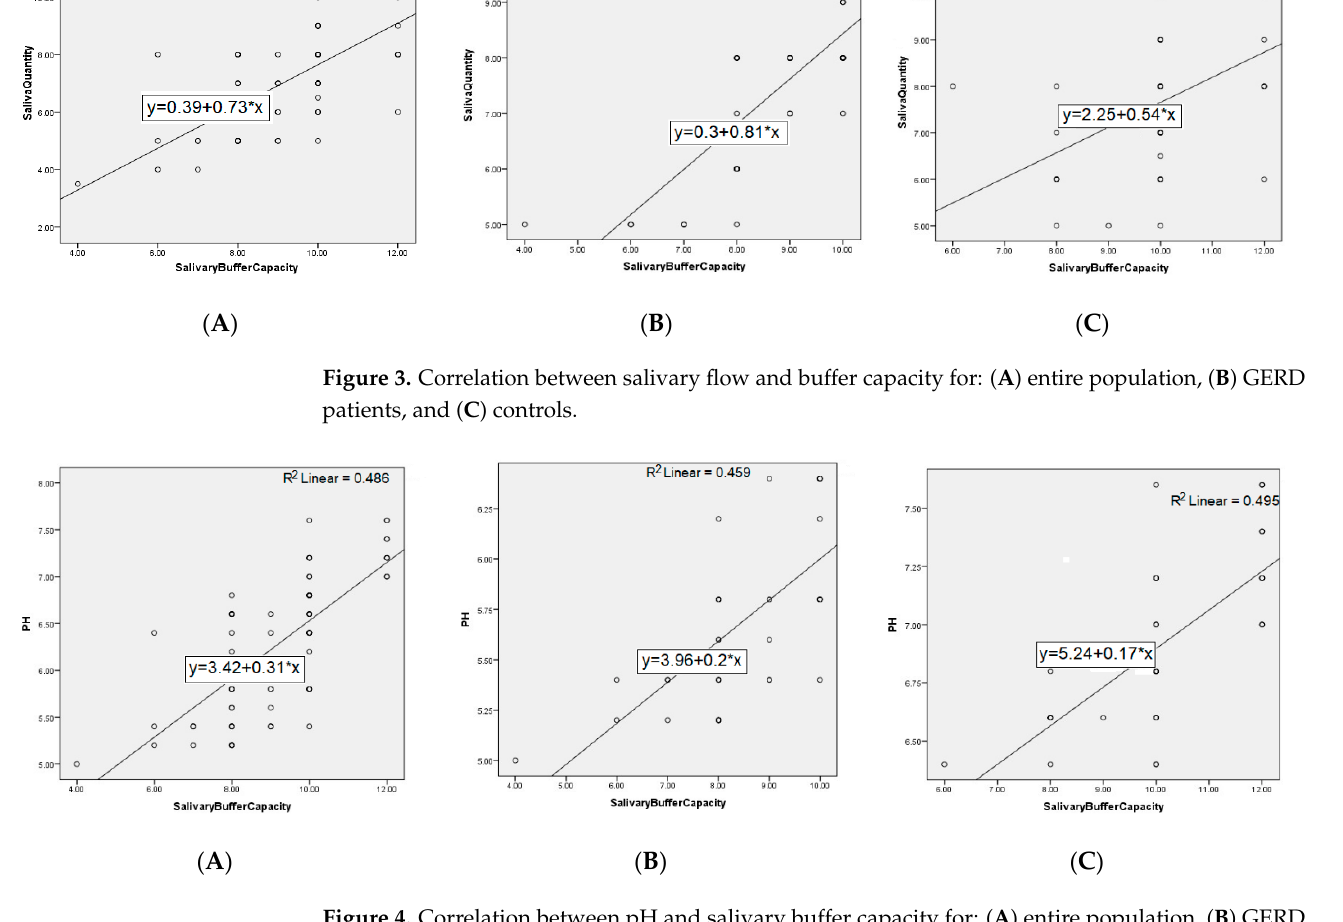
Figure 4. Correlation between pH and salivary buffer capacity for: ( A ) entire population, ( B ) GERD patients, and ( C ) controls.